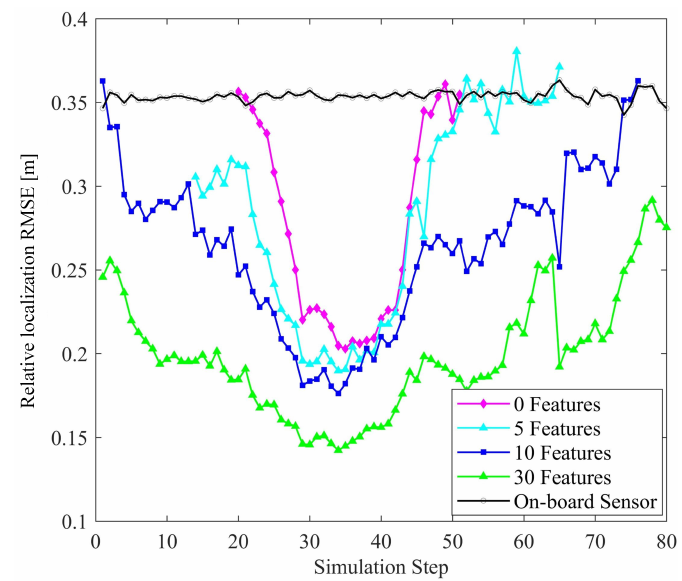
Figure 13. Effect of the number of features on perception accuracy.